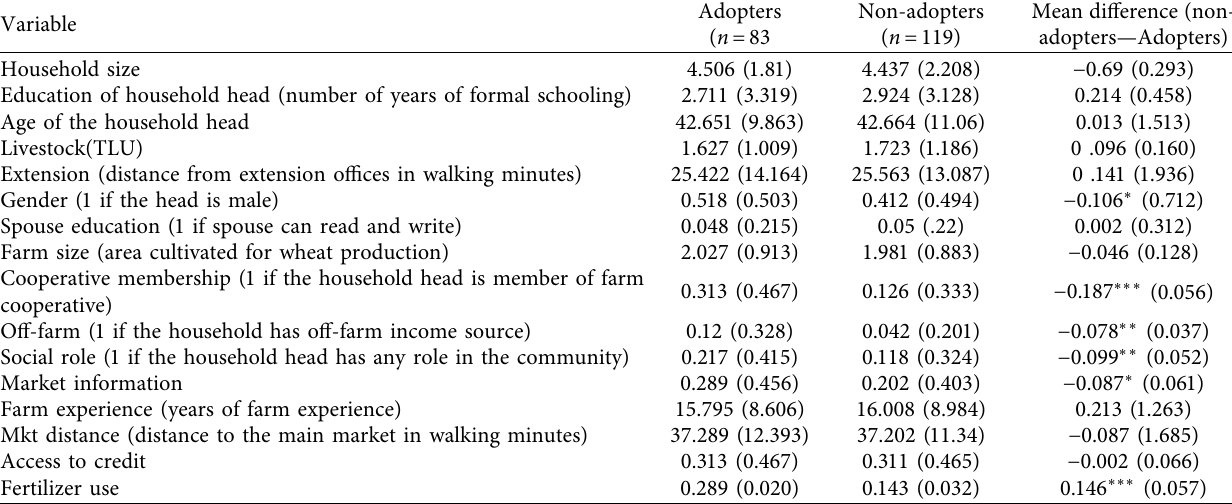
Table 1: Balance test of covariates.